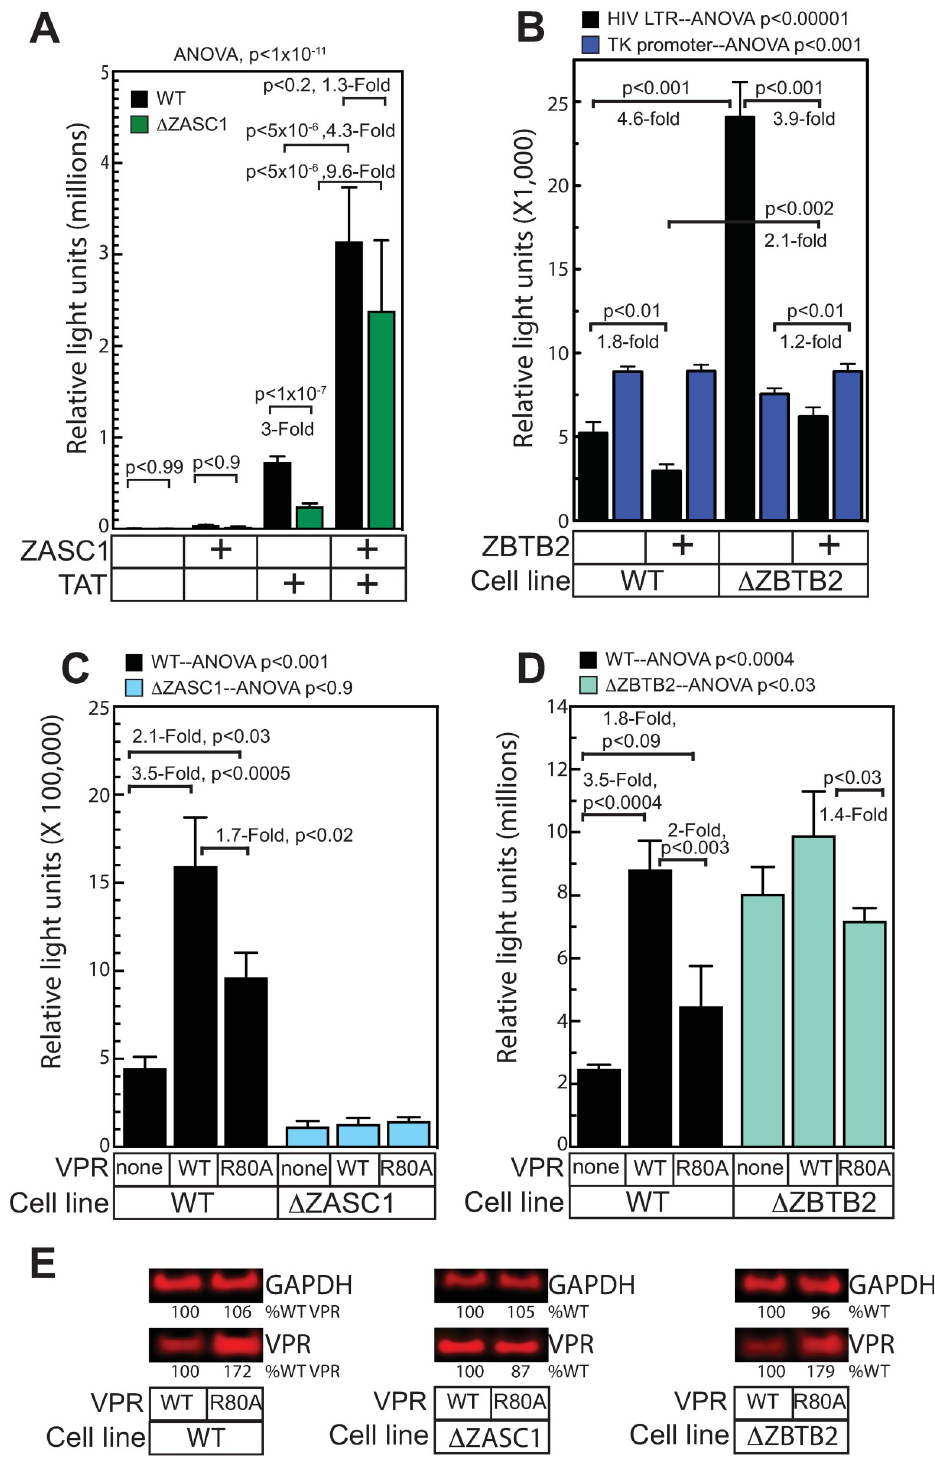
Fig 6. ZASC1, ZBTB2 and Vpr regulate HIV-1 LTR promoter activity. (A) WT Jurkat and Δ ZASC1 Jurkat cells transfected with reporter plasmids expressing Gaussia luciferase from the HIV-1 promoter and with the ZASC1 and/or TAT expression plasmids indicated in the table at the bottom. Raw relative light units of HIV-1 LTR promoter-driven reporter gene expression for each cell line was reported in the presence and absence of ZASC1 and TAT. (B) WT and Δ ZBTB2 Jurkat cells were transfected with reporter plasmids containing HIV-1 promoter-driven Gaussia luciferase